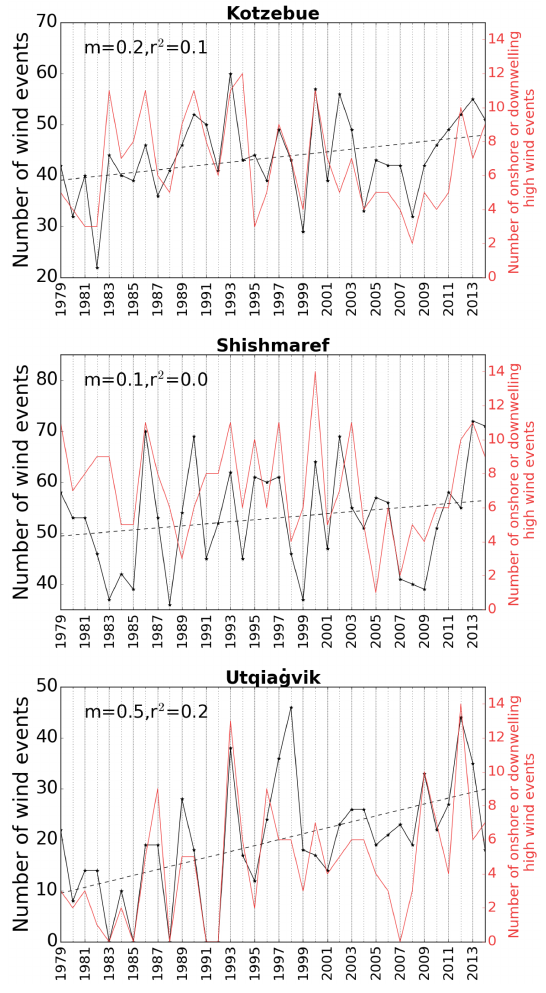
Figure 8. The number of wind events capable to cause significant erosion for Kotzebue, Shishmaref, and Utqia˙gvik. Wind events were defined as being at least 6h or longer of sustained winds exceeding 10ms − 1 including lulls of over 7ms − 1 shoulder events, as defined in Atkinson (2005). Also shown is the number of these events which have winds in the 90 ◦ window between the two directions of com- ing from alongshore (downwelling) and directly onshore toward the community from the ocean, setting up water along the coast. Wind data are from WRF-downscaled ERA-Interim; sea ice data are from